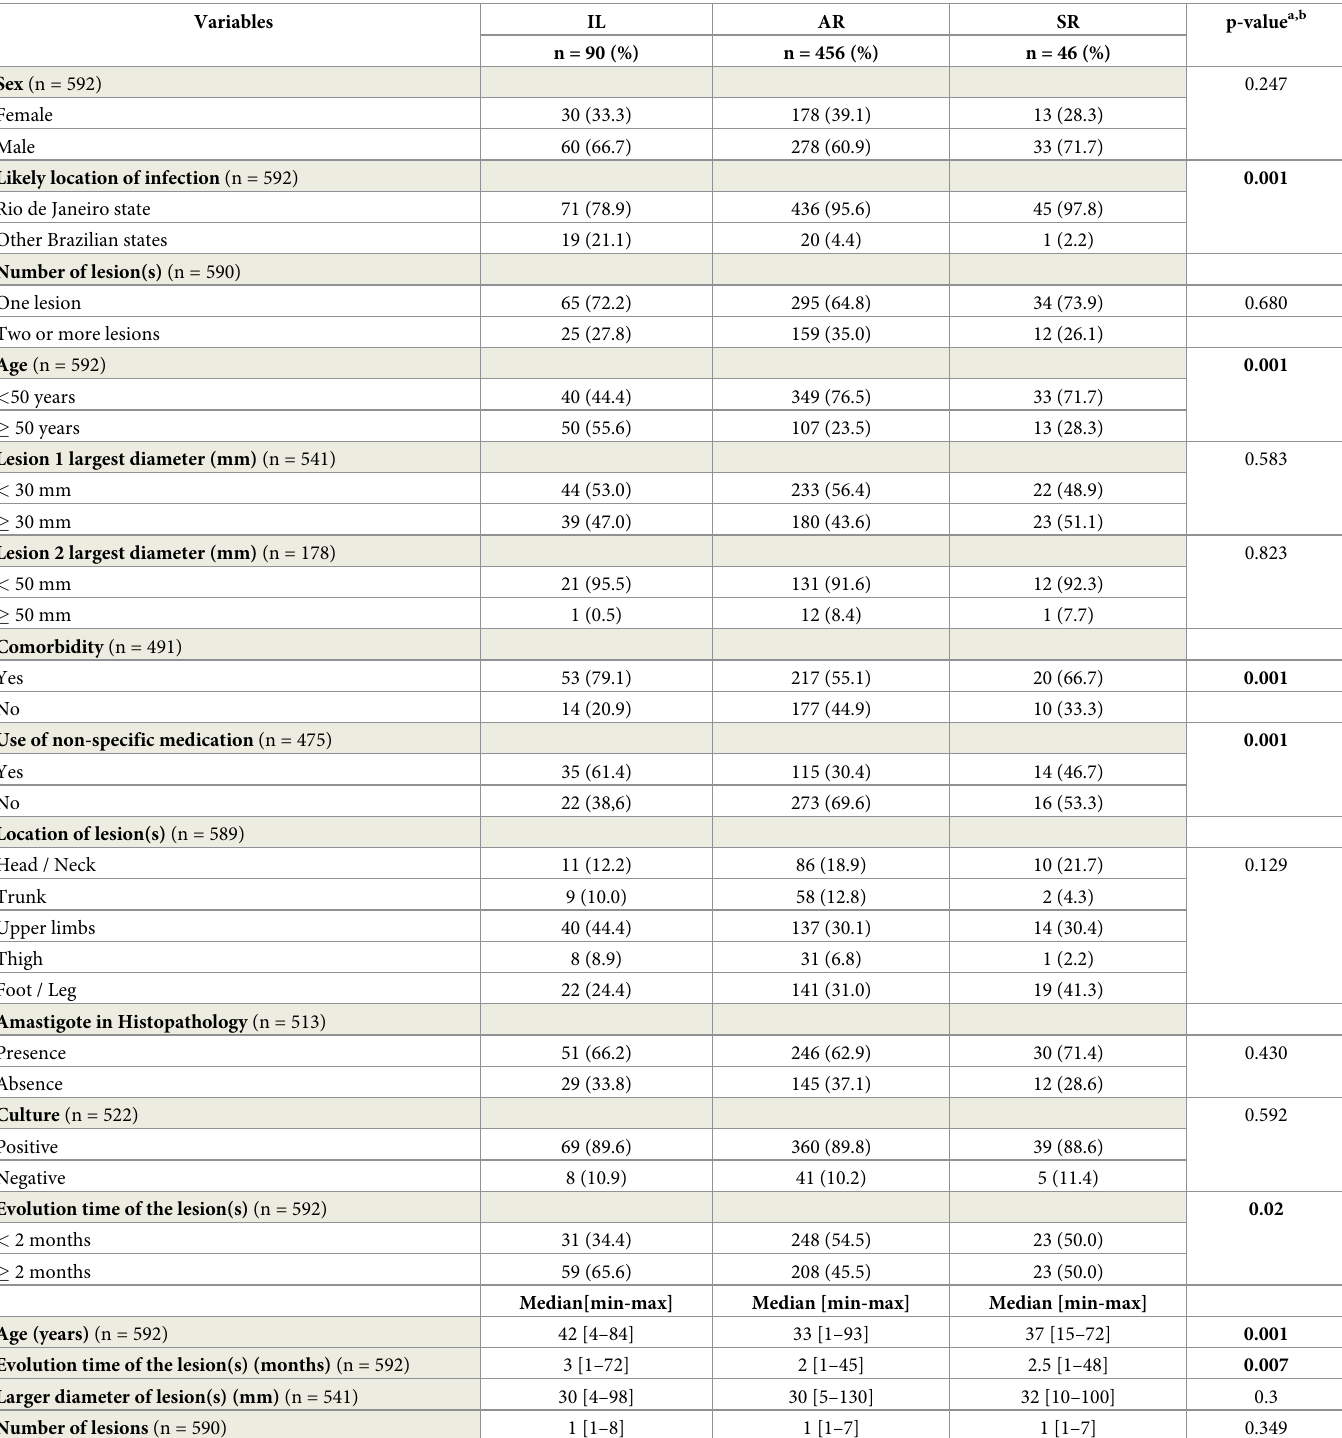
Table 1. Distribution of the clinical and laboratory characteristics of 592 patients according to group